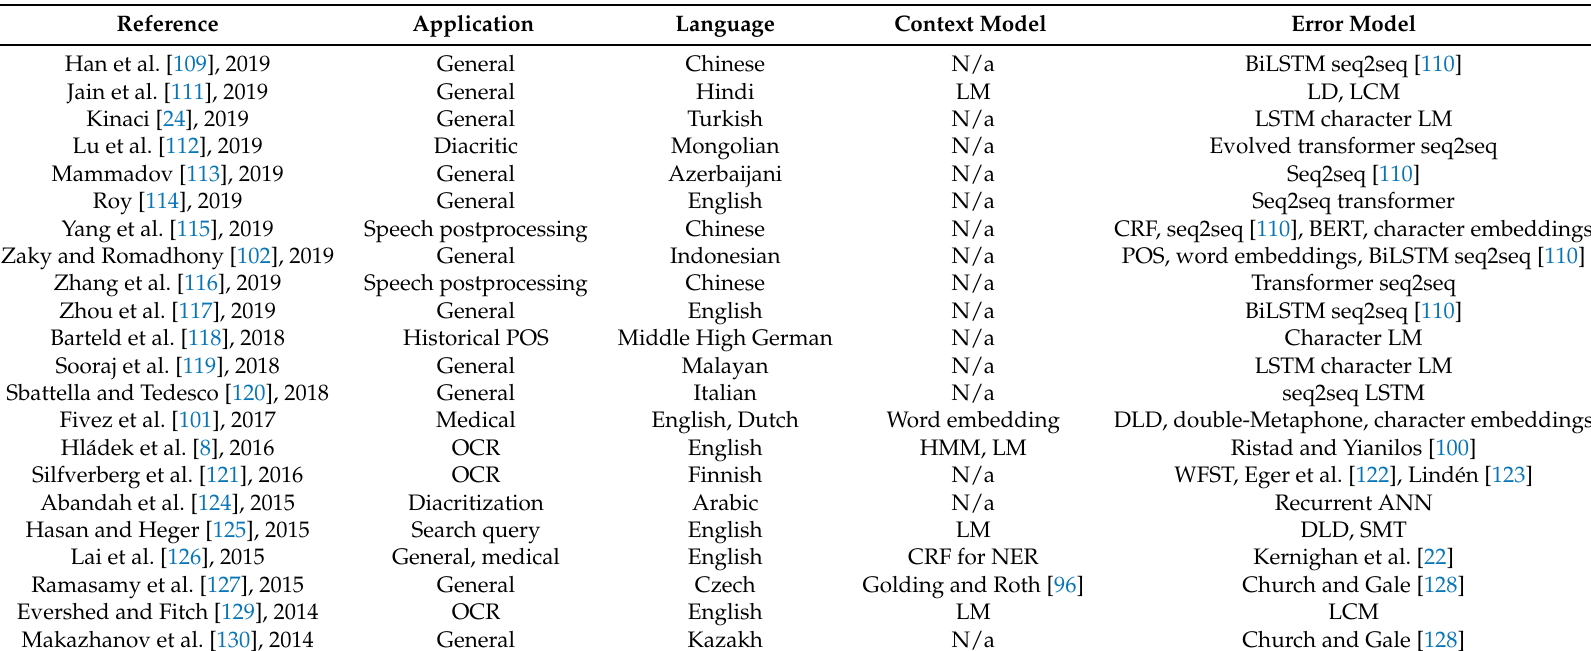
Table 5. Spelling correction systems with learning of context model and error model—part